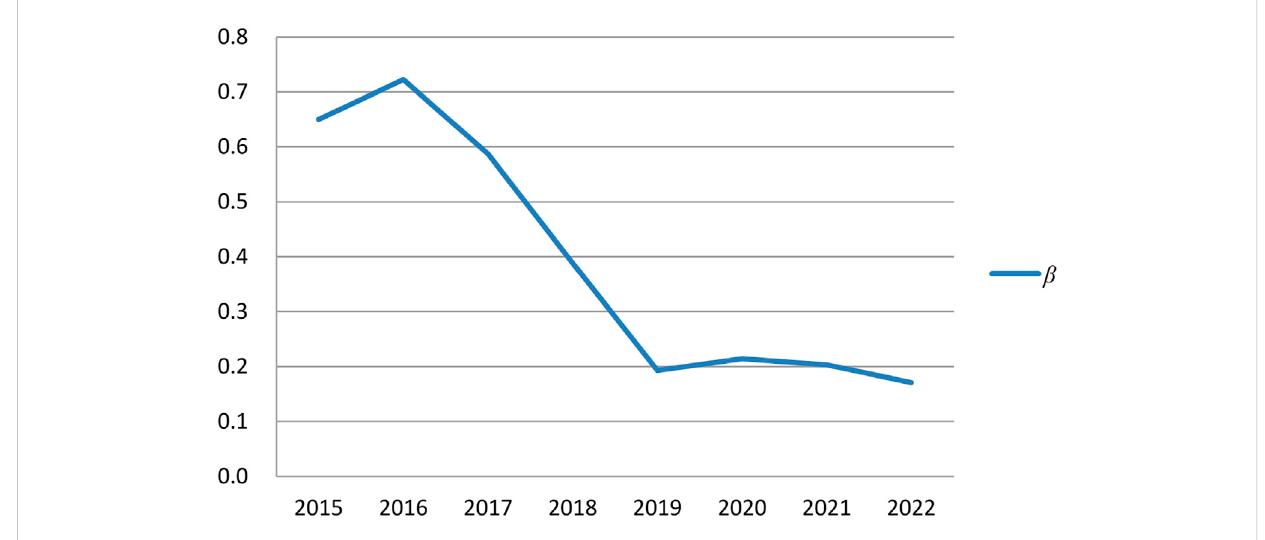
FIGURE 2 Trend of subsidy coef fi cient under the current subsidy scheme.